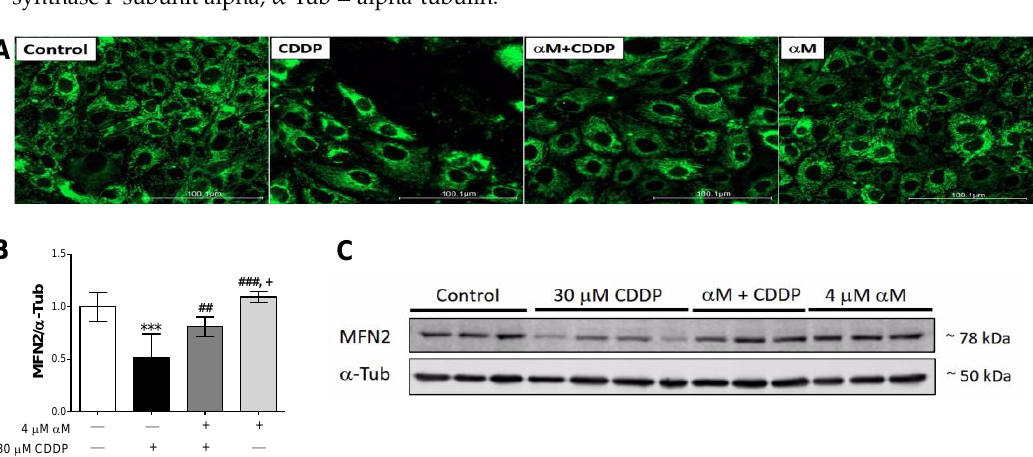
Figure 6. CDDP-induced toxicity is related to a decrease of mitochondrial fusion. LLC-PK1 cells were treated with α M, CDDP or both for 24 h. After treatment, ( A ) representative micrographs of MitoTracker green, mitochondrial mass marker, at 20x and posterior zoom 1:1 and western blotting of ( B ) Fusion marker, mitofusin 2 (MNF2) level and representative blot in ( C ). The data are presented as mean ± SD, n = 6–8. *** p < 0.001 vs. control. ### p < 0.001, ## p < 0.01 vs. CDDP. + p < 0.05 vs. ( α M + CDDP). α -Tub = alpha-tubulin.